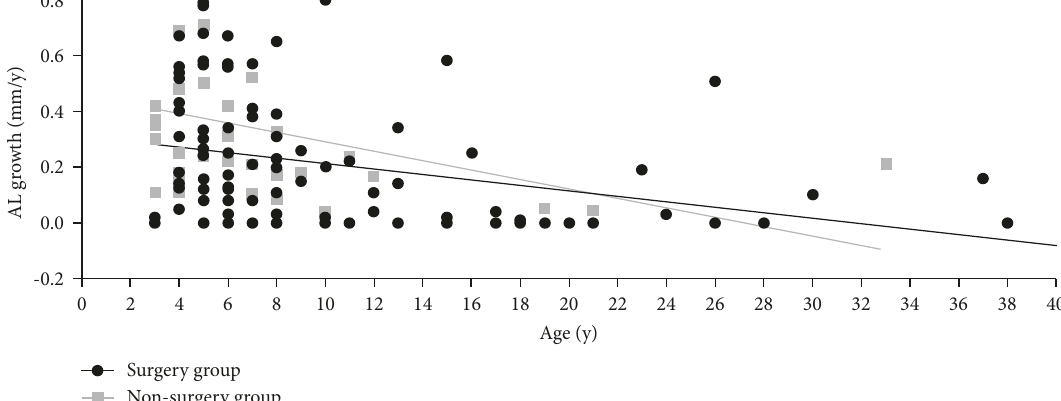
Figure 4: Scatter plot between the growth rate of axial length and age in the surgery group and the nonsurgery group of CEL patients.